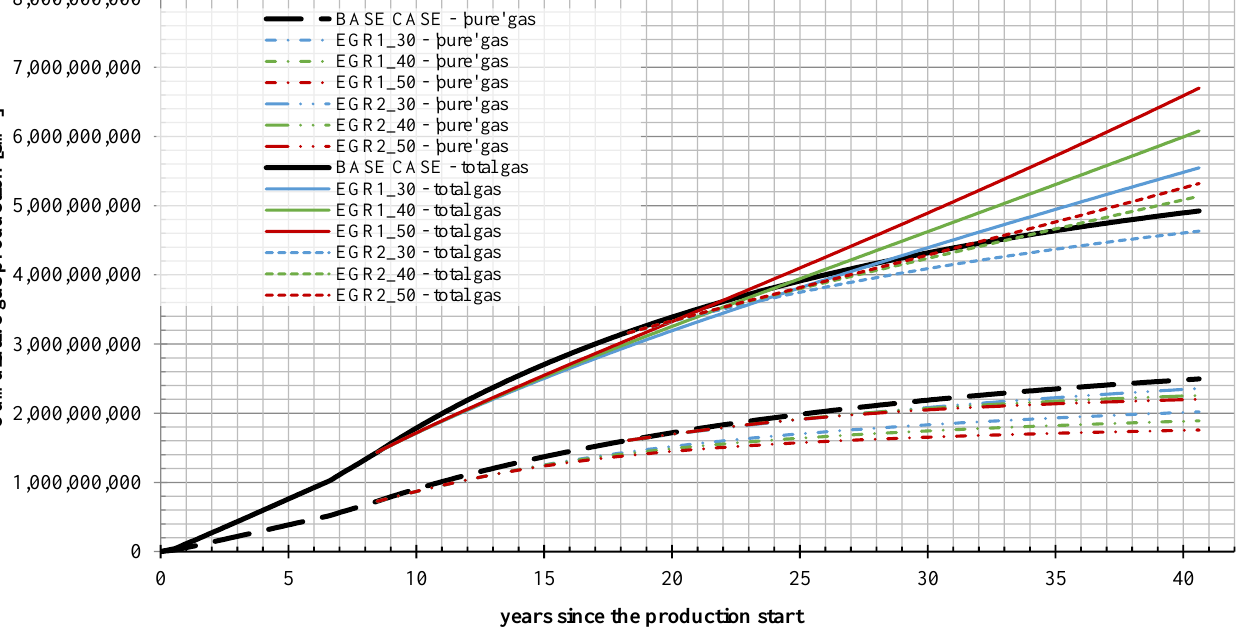
Figure 3. Total and ‘pure’ gas cumulative production.